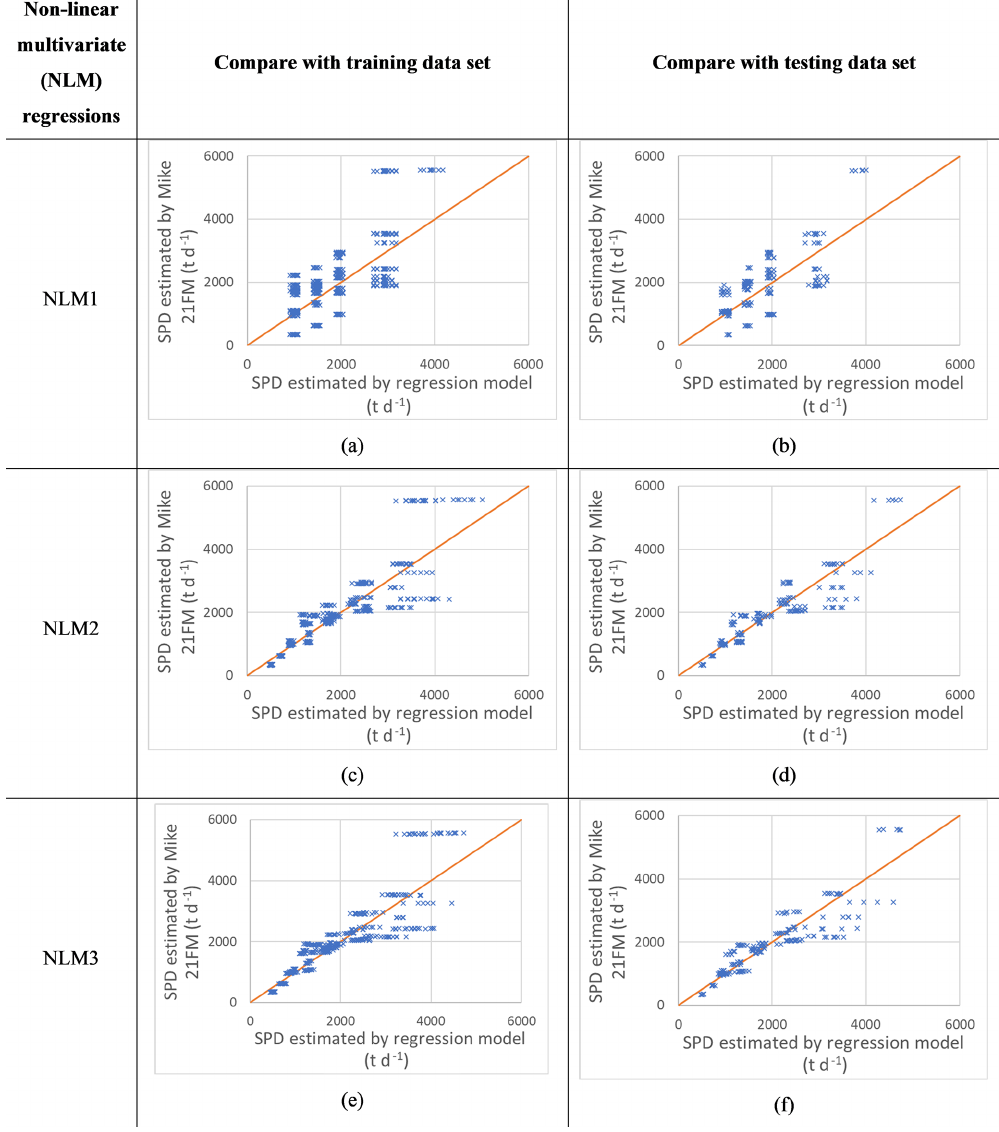
Figure 5. Comparing the values for SPD, calculated from the hydro-morphological model results against the values for SPD, estimated with the NLM regressions, for all 10 sets of training and testing data samples. The line depicts the 1 : 1